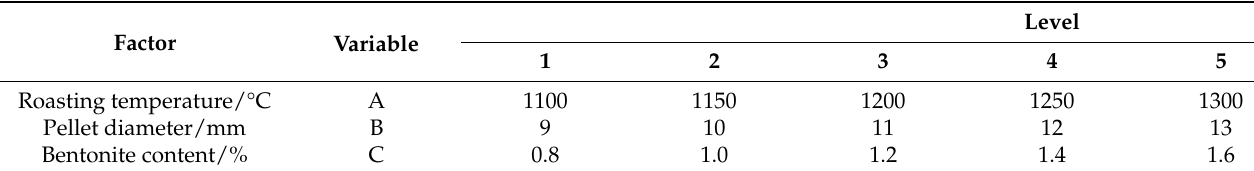
Figure 1. Limonite pellet ‐ roasting process.